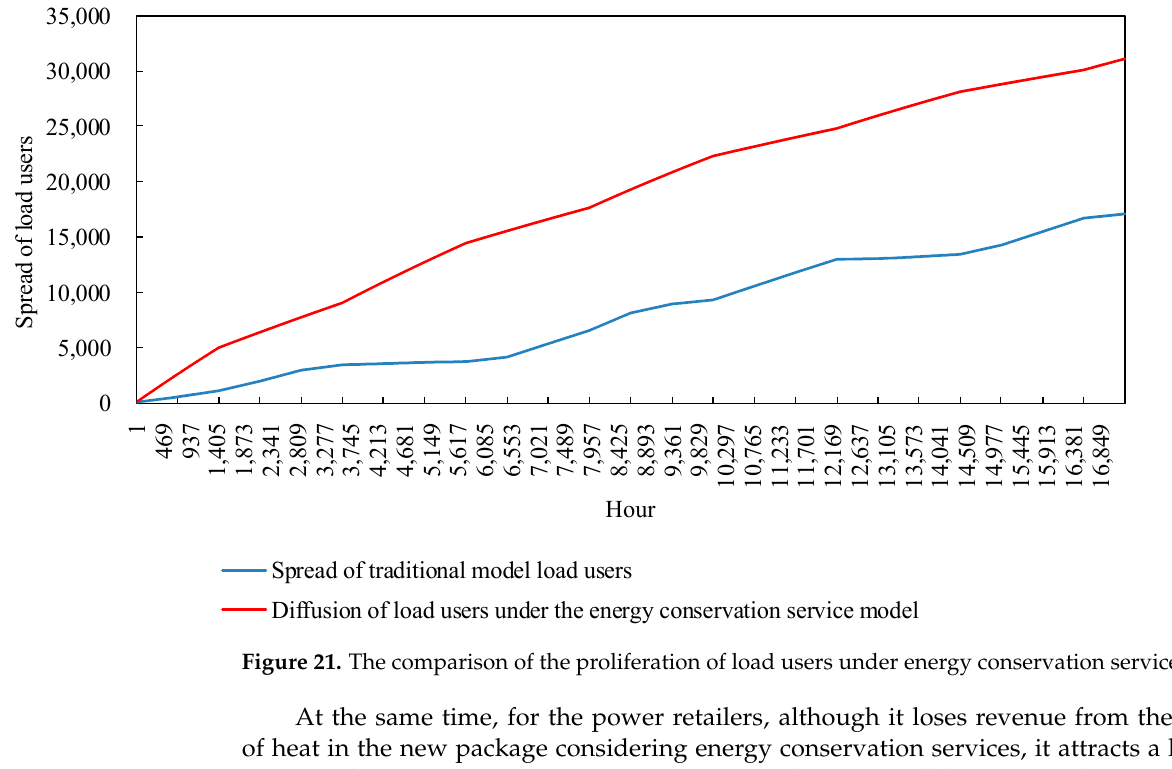
Figure 21. The comparison of the proliferation of load users under energy conservation services.